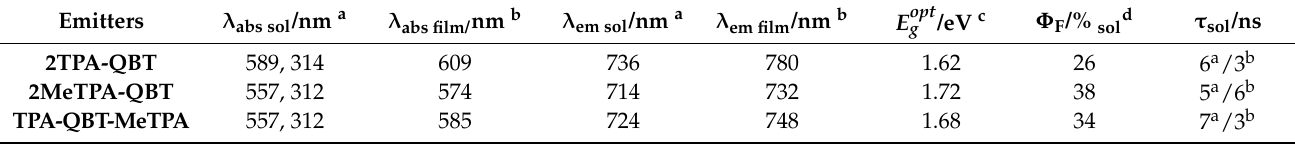
Table 2. Photophysical properties for the three